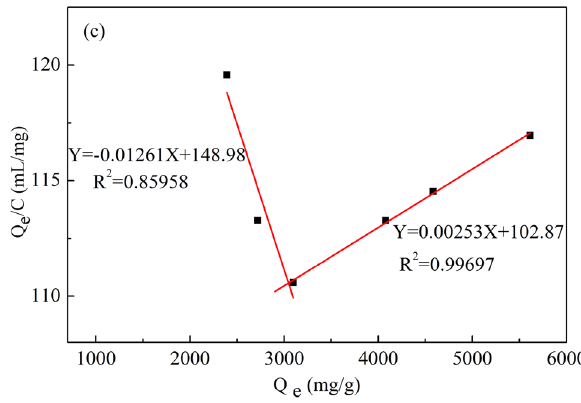
Figure 7: Scatchard fi tting isotherm of Ni ( II )- IIP 5